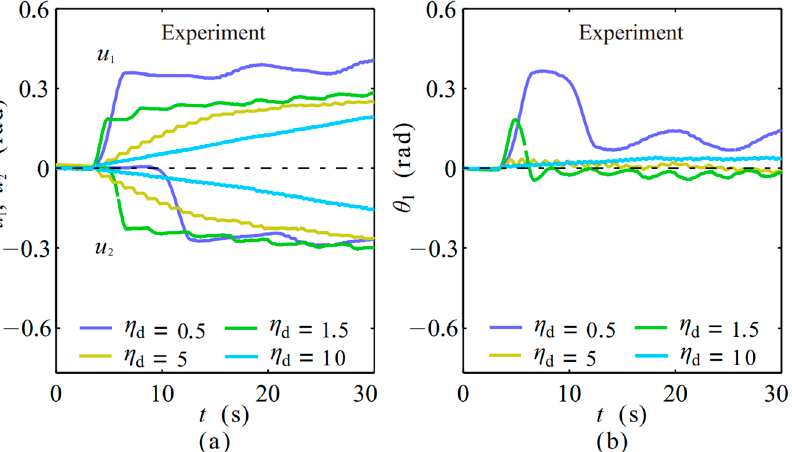
Figure 11. Serial-stiffness-switch system experiment results for harmonic disturbances under different η d , here (cid:98) M d = 0.05Nm and η s = 100. ( a ) Deformations of the two springs, u 1 and u 2 ; ( b ) displacement of the primary plate, θ 1